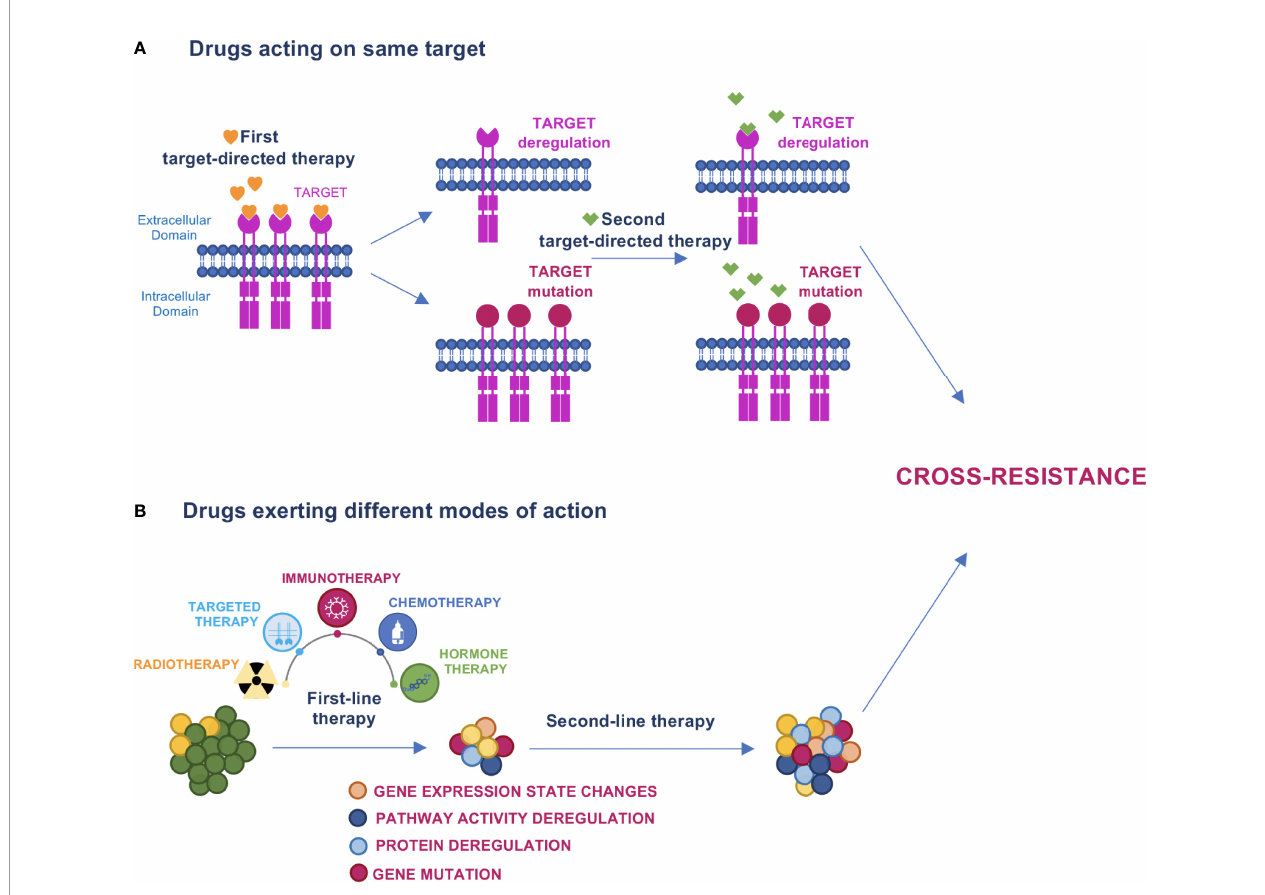
FIGURE 1 | Models of cross – resistance. (A) When drugs acting on the same target are sequentially administered, the fi rst drug can induce target deregulation or mutation that causes escape from therapy and cross – resistance to the subsequent drug. (B) Cancer therapy promotes evolutionary dynamics fostering mutations, protein or pathway activity deregulations, and changes in gene expression states that can determine cross – resistance to the next